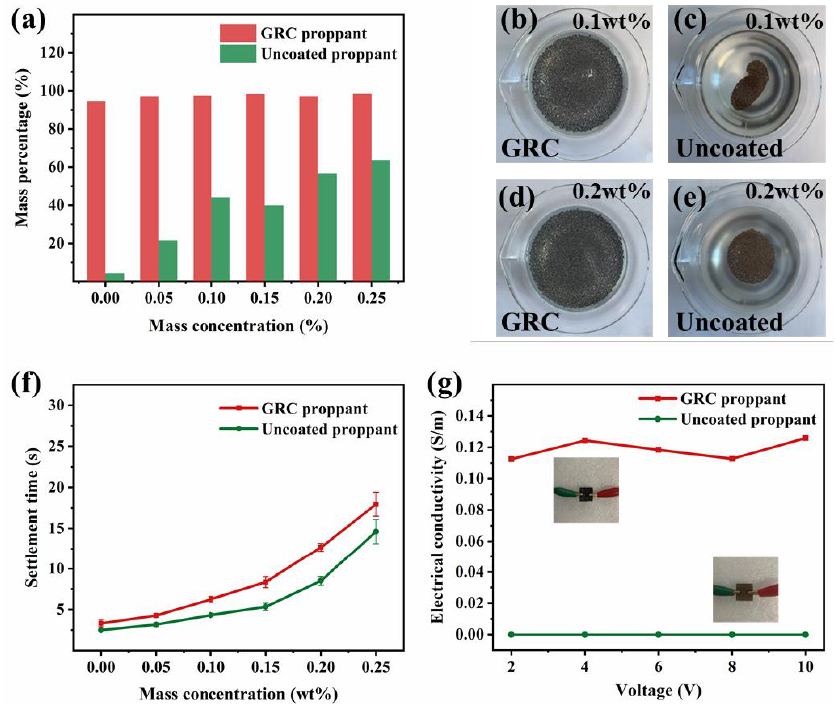
Figure 5. ( a ) Mass percentage of proppant suspended on different guar gum solutions. ( b , c ) GRC and uncoated proppant suspended on the surface of guar gum solution at 0.1 wt%. ( d , e ) GRC and uncoated proppant suspended on the surface of guar gum solution at 0.2 wt%. ( f ) Settlement time of uncoated proppant and GRC proppants in guar gum solution with different mass concentrations. ( g ) Electrical conductivity of uncoated proppant and GRC proppant under different voltage.